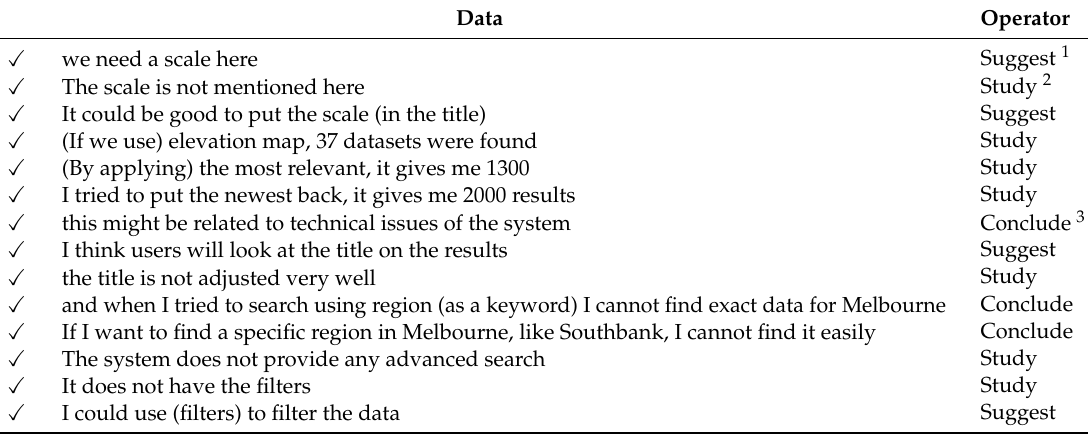
Table 4. Example of script analysis of the TAP